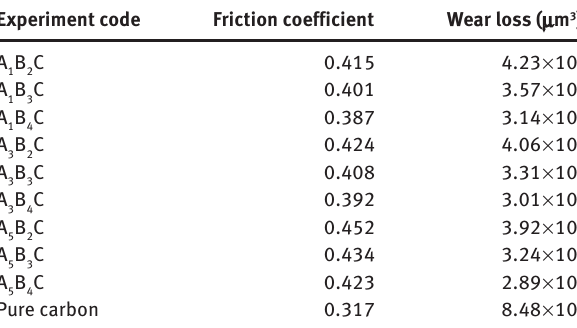
Table 2: Friction coefficient and wear loss of the pantographs. Experiment code Friction coefficient